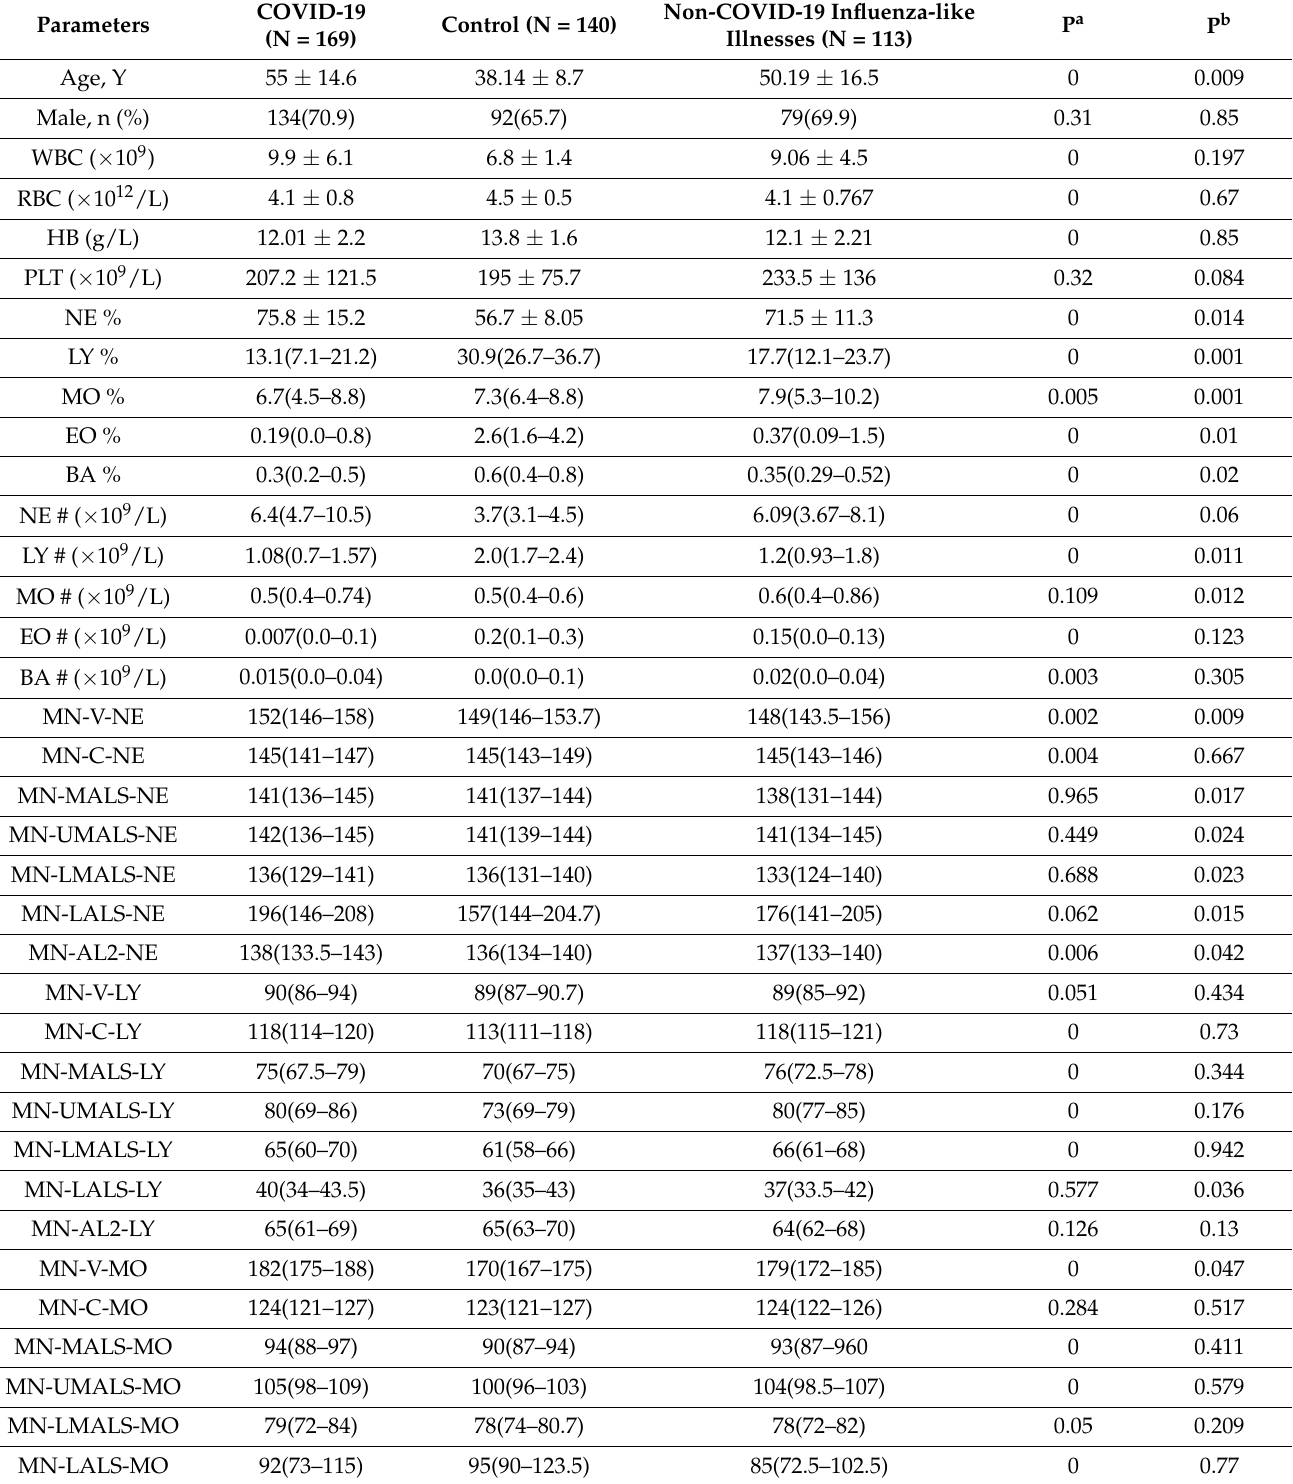
Table 1. Comparison of the demographic and hematological parameters of COVID-19, non-COVID-19 Influenza-like illnesses and Healthy